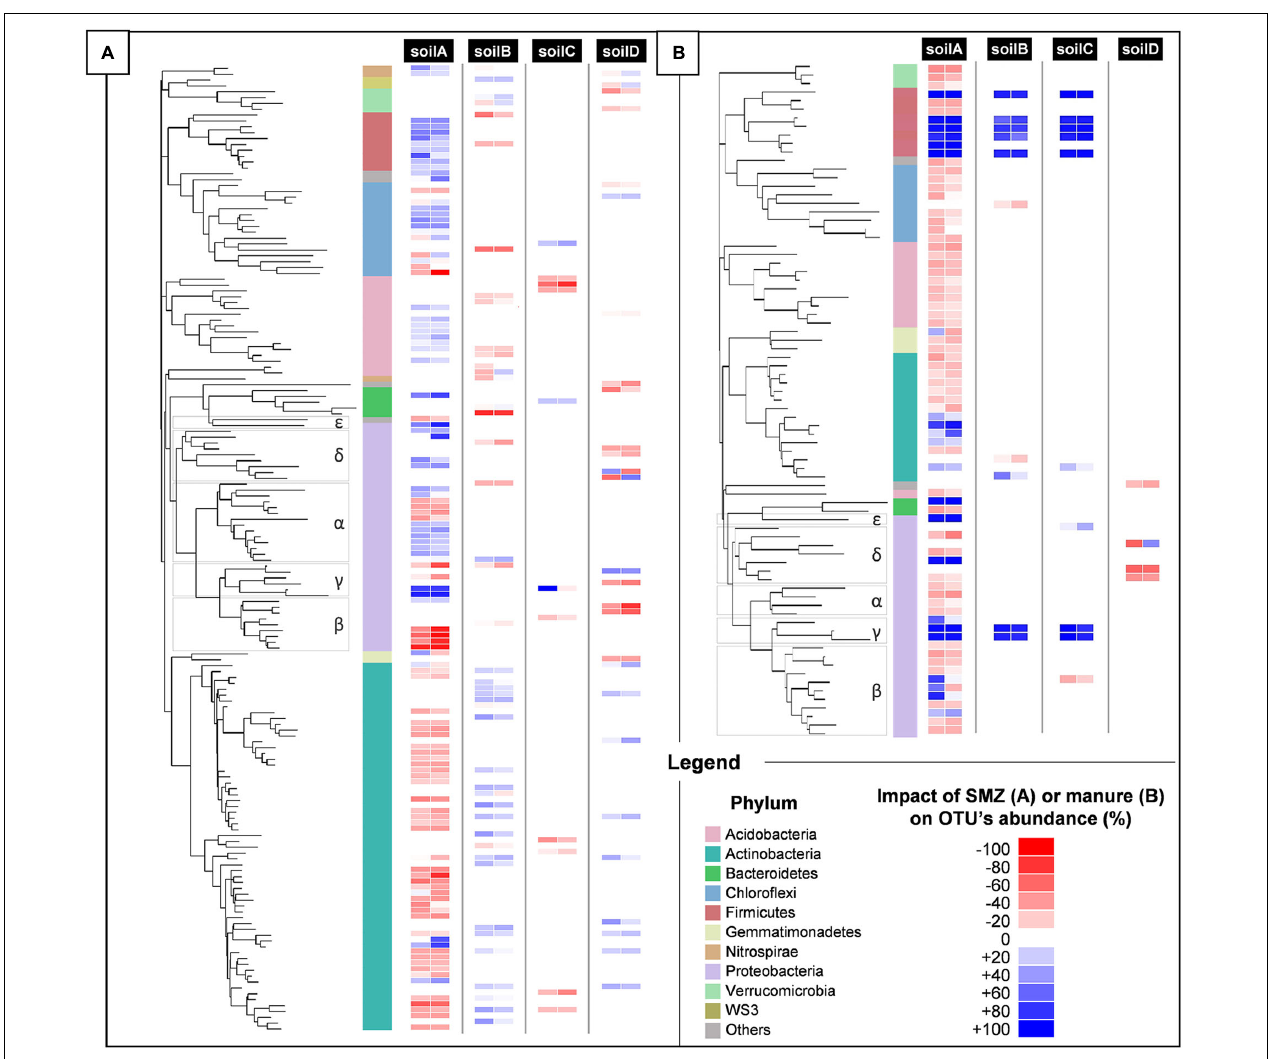
FIGURE 3 | Phylogenetic placement of bacterial OTUs significantly impacted by SMZ (A) or manure spreading (B) in the four different types of soils, A, B, C, and D, after 1 month of incubation. Discriminant OTUs between treatments were assessed by ANOVA ( p < 0.05). The phylum-level affiliation of each OTU is indicated by different colors in the left strip. For each OTU in each soil, the impact of SMZ (A) or manure spreading (B) is represented by a two-strip heatmap to distinguish conditions without (left strip) and with (right strip) manure spreading (A) or SMZ (B) . Red represents a negative impact of the treatment on the OTU abundance; blue, a positive impact. For each condition and OTU, the impact is reported as the difference in OTU abundance means between treated and non-treated samples divided by its maximum over the two conditions. Color intensities show the strength of the